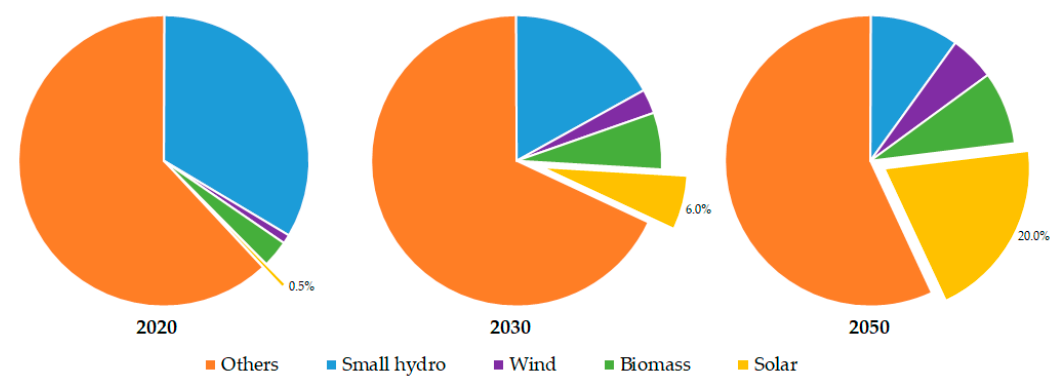
Figure 12. Share of Electricity production by renewables under REDS.